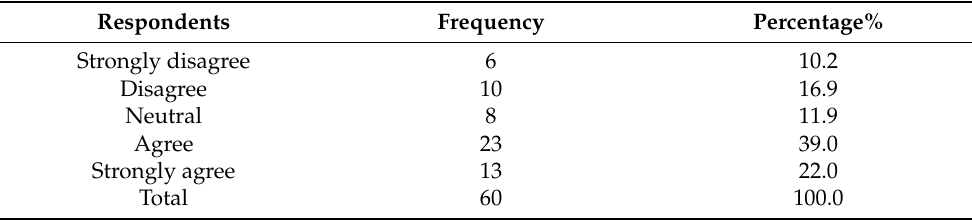
Table 14. Bank loans are commonly available and may be used to establish a